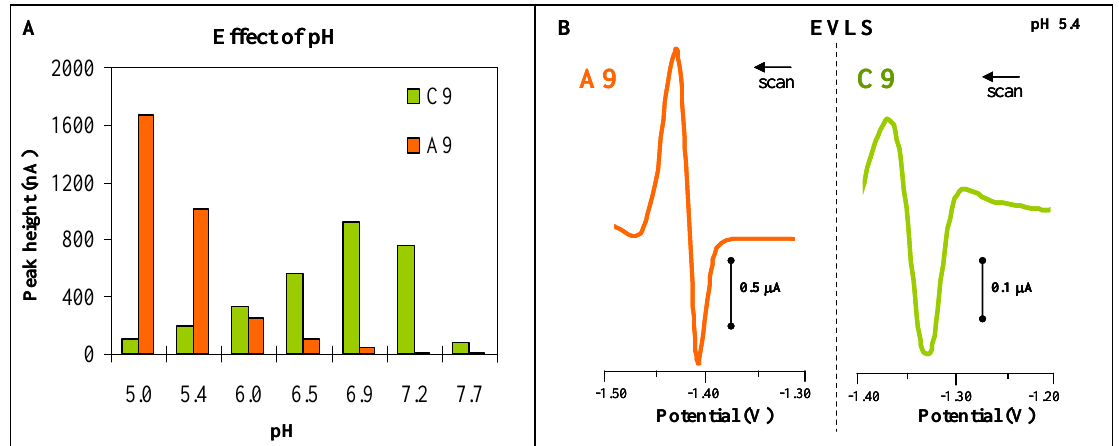
Figure 2. Analysis of homo-oligodeoxynucleotides A9 and C9. A ) Influence of pH (0.1 M phosphate buffer) on peak heights of ODNs. D ) Elimination voltammograms of A9 and C9 suitable for